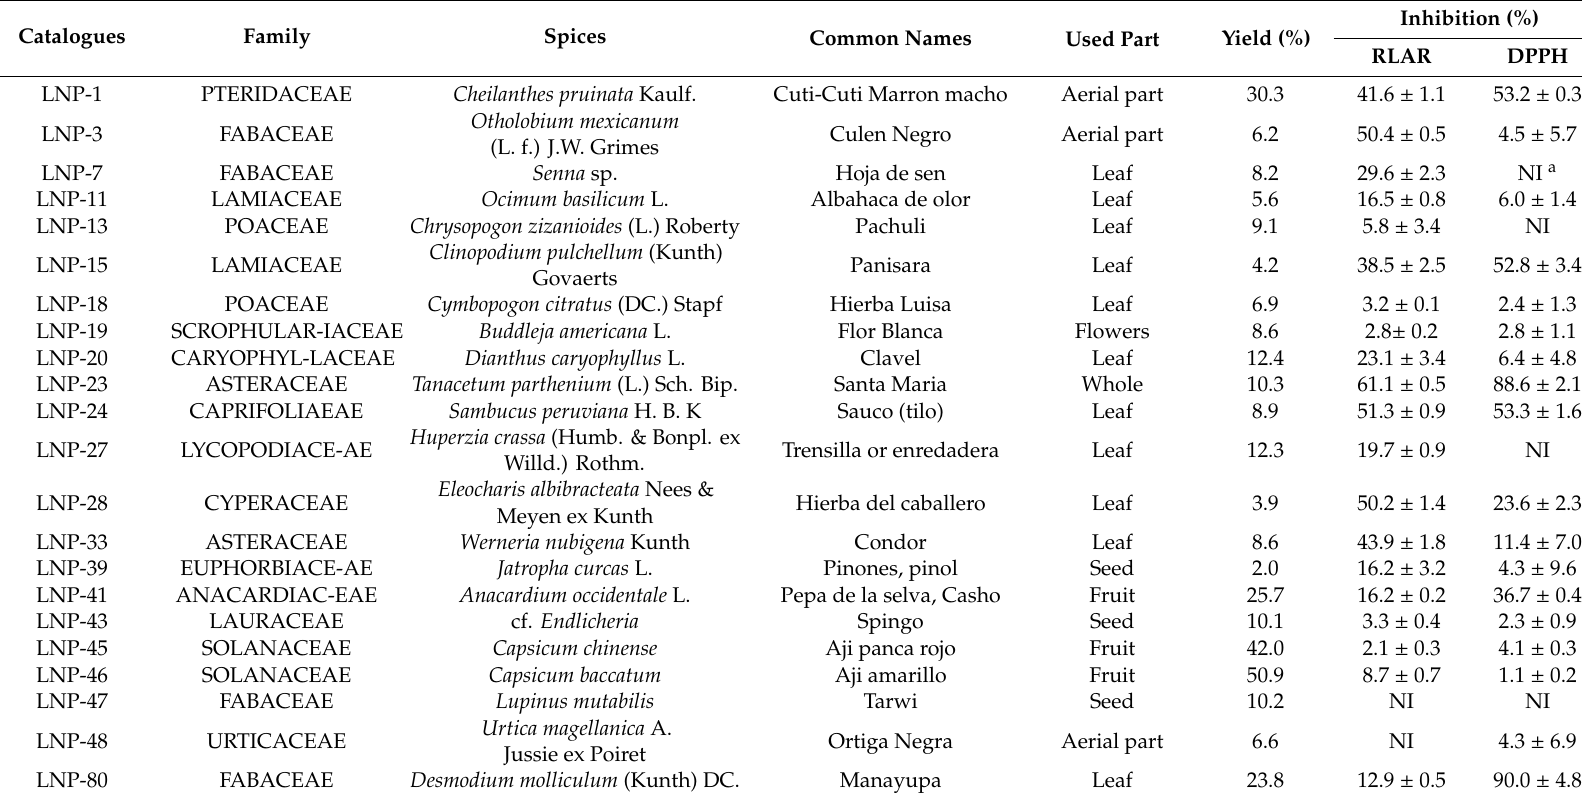
Table 1. The Rat Lens Aldose Reductase (RLAR), 2,2-diphenyl-1-picrylhydrazyl (DPPH) radical scavenging activities, and yields of 22 Peruvian plants extracts from La